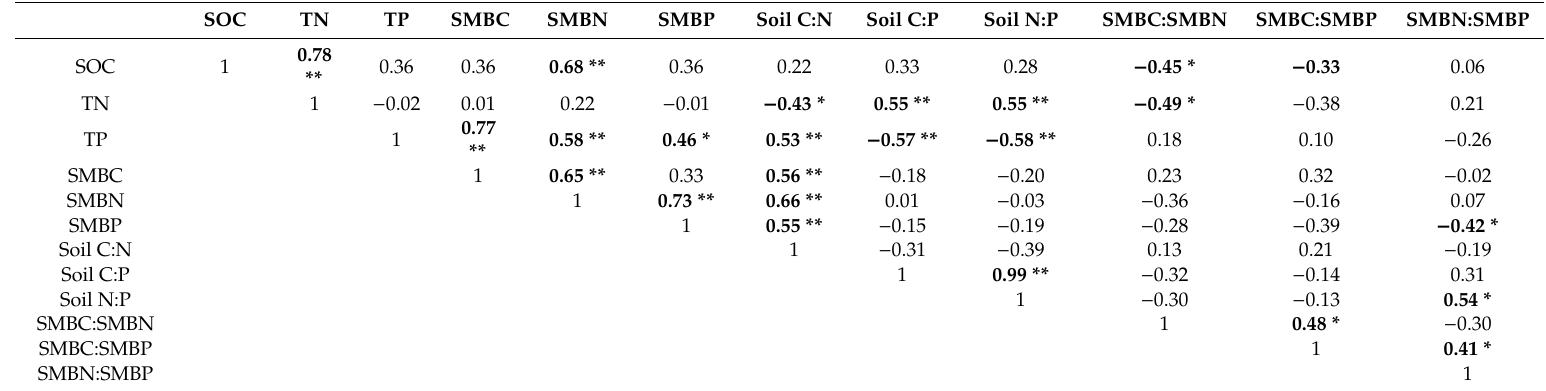
* and ** indicate correlation is significant at p < 0.05 and p < 0.01,